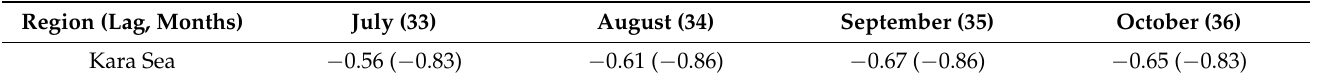
Table 3. Correlation coefficients between SST in tropical North Atlantic in October and monthly sea ice extent with a lag of 33–36 months (1979–2021). In brackets—after smoothing with 3-year window. Trend is not removed.